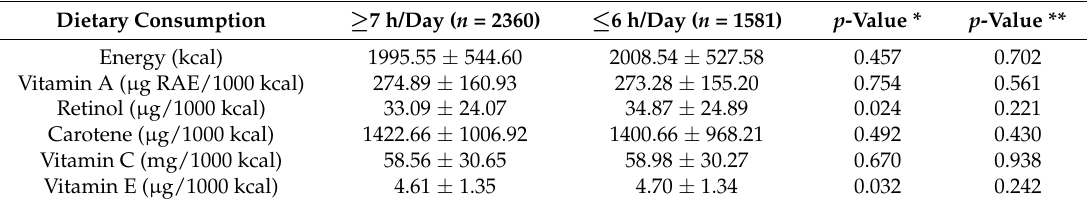
Table 3. Dietary antioxidant consumption according to sleep duration in Korean